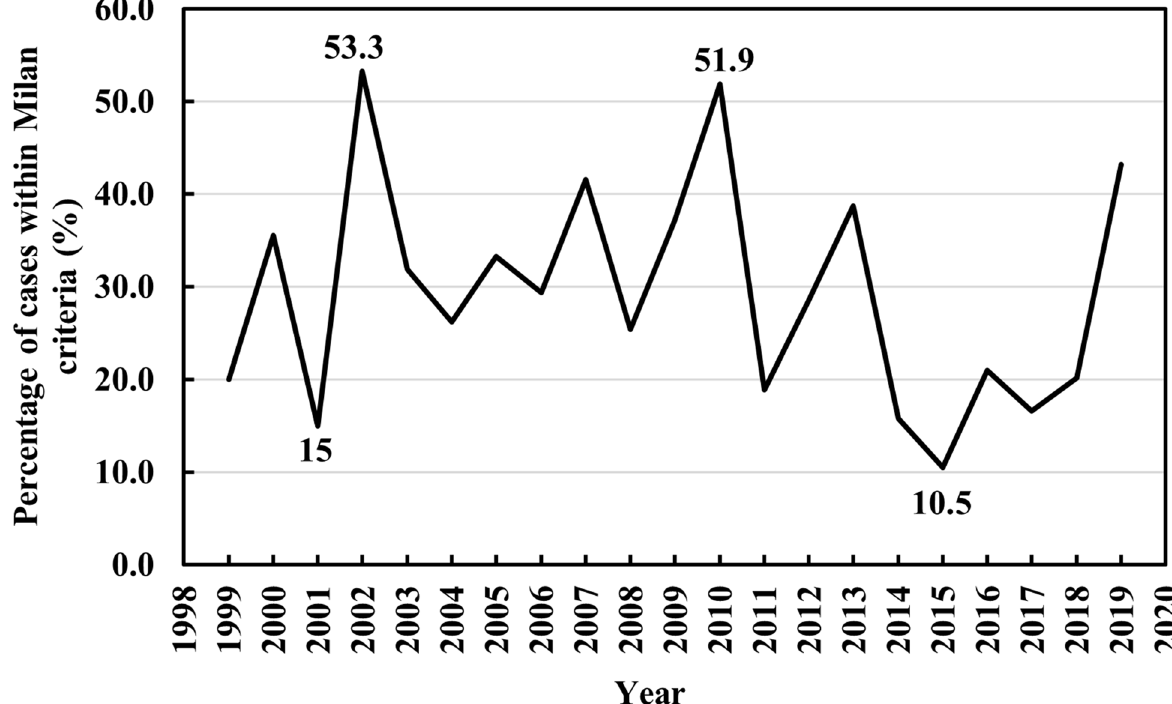
Fig. 8 The percentage of cases within Milan criteria per year Fig. 8 This figure showed that, the highest percentage was 53.3% in 2002 and the lowest was 10.5% in